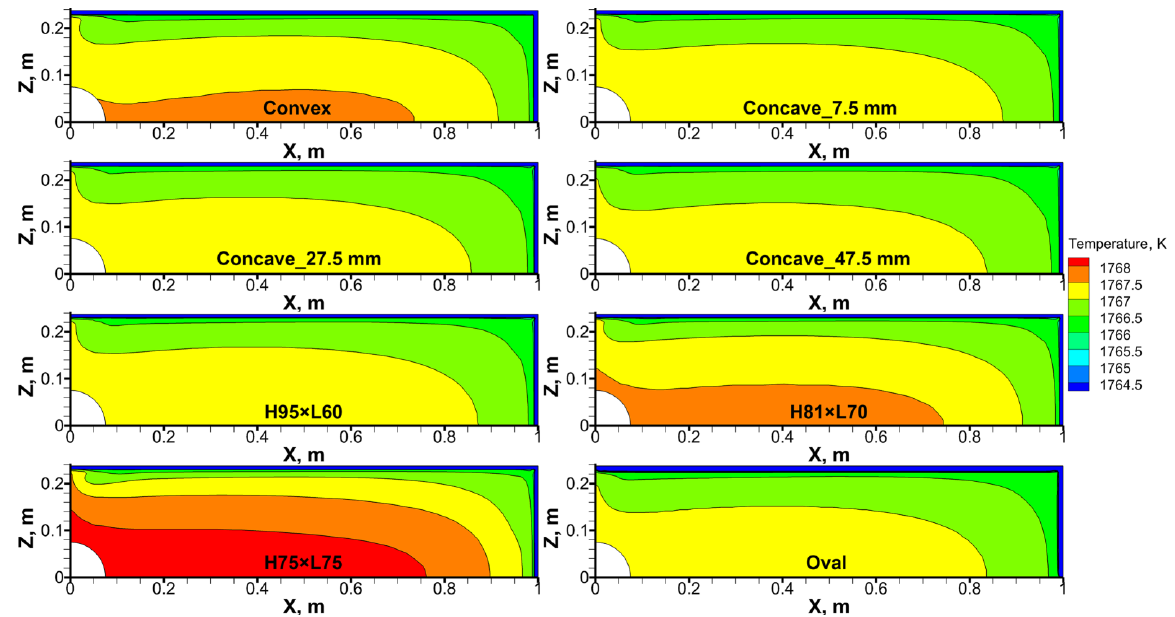
Figure 5. Temperature distributions on the meniscus under different conditions of SEN bottoms and port shapes.